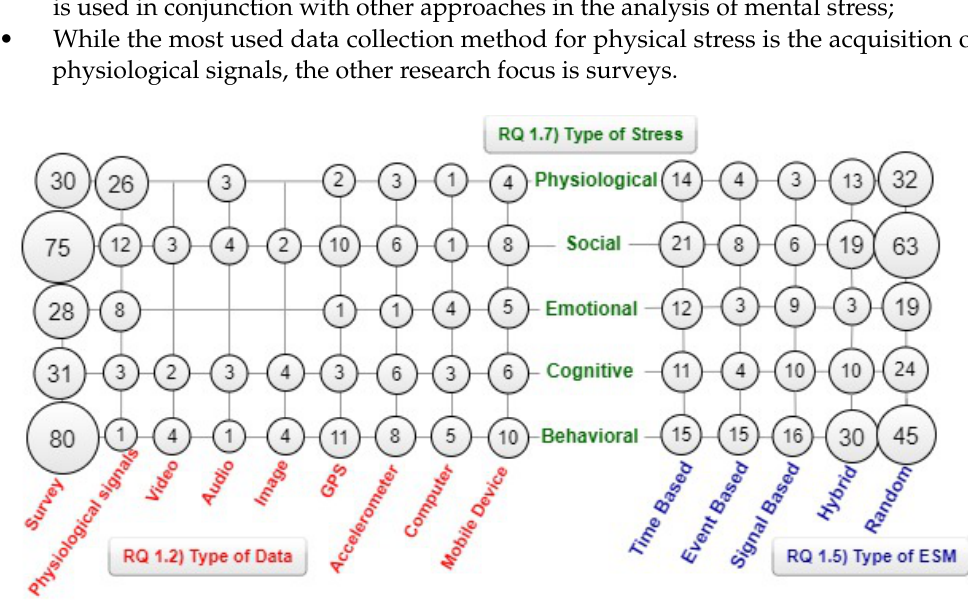
Figure 14. Mapping results obtained from the combination of Q2, Q5, and